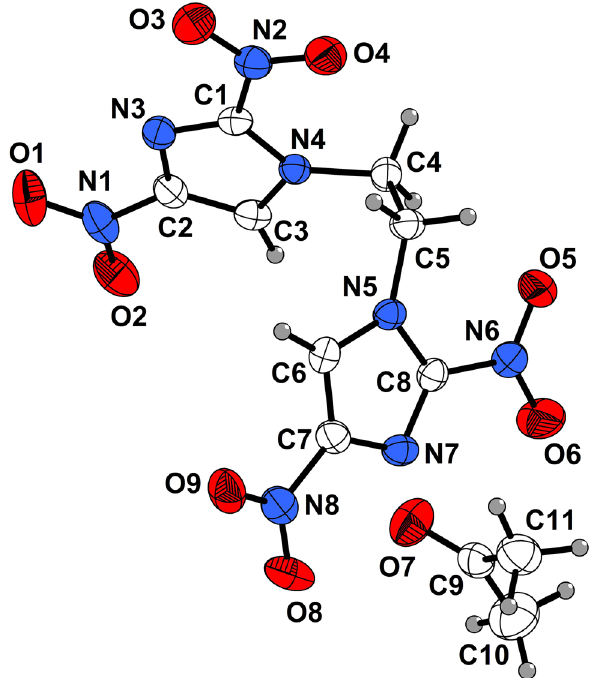
Table  : Data collection and